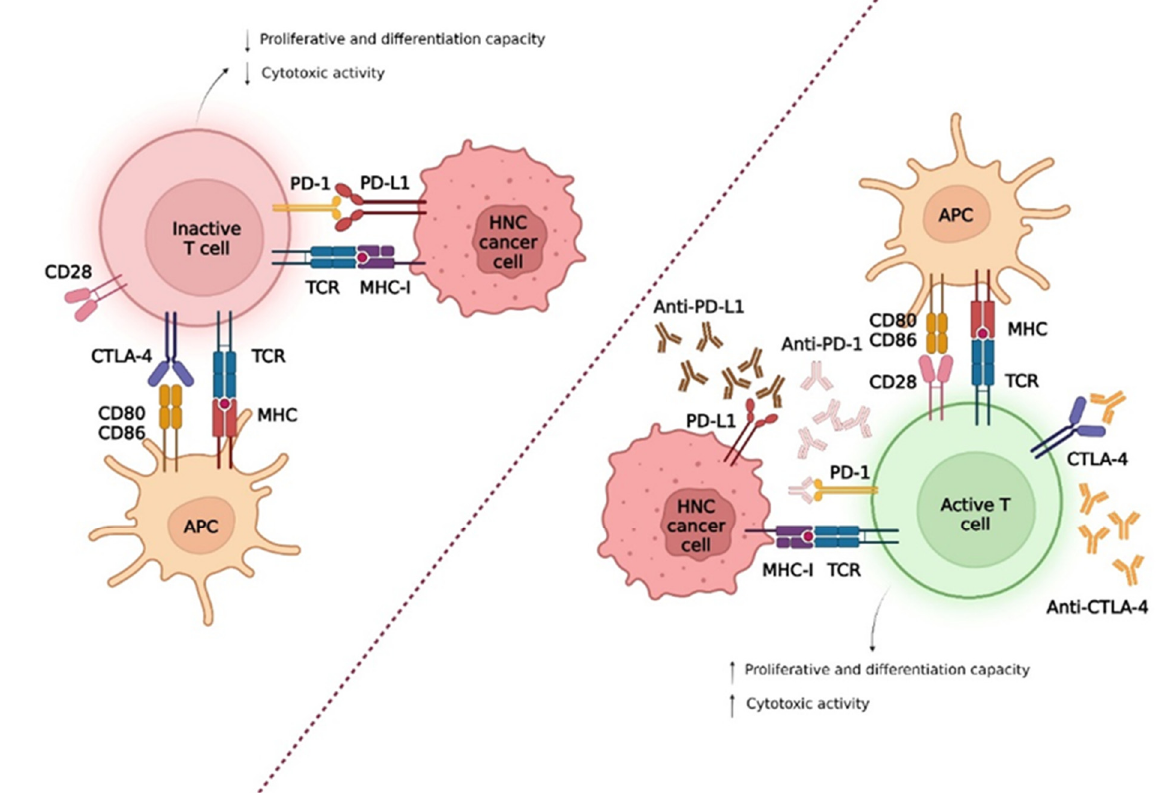
Figure 2. Tumour evasion mechanisms, in patients with head and neck cancer, from immunological checkpoints. The interaction between programmed death-1 (PD-1), expressed in T cells, with the programmed death-ligand 1 (PD-L1) promotes the inactivation of T cells and consequent proliferation. The inactivation of T cells mediated by cytotoxic T lymphocyte antigen 4 (CTLA-4) occurs because CTLA-4 has a higher affinity for CD80/CD86 ligands compared to CD28. In this sense, the development of anti-PD-1/PD-L1 and anti-CTLA-4 antibodies prevent the occurrence of these interactions, thus allowing the reestablishment of antitumour immunity mediated by T cells.